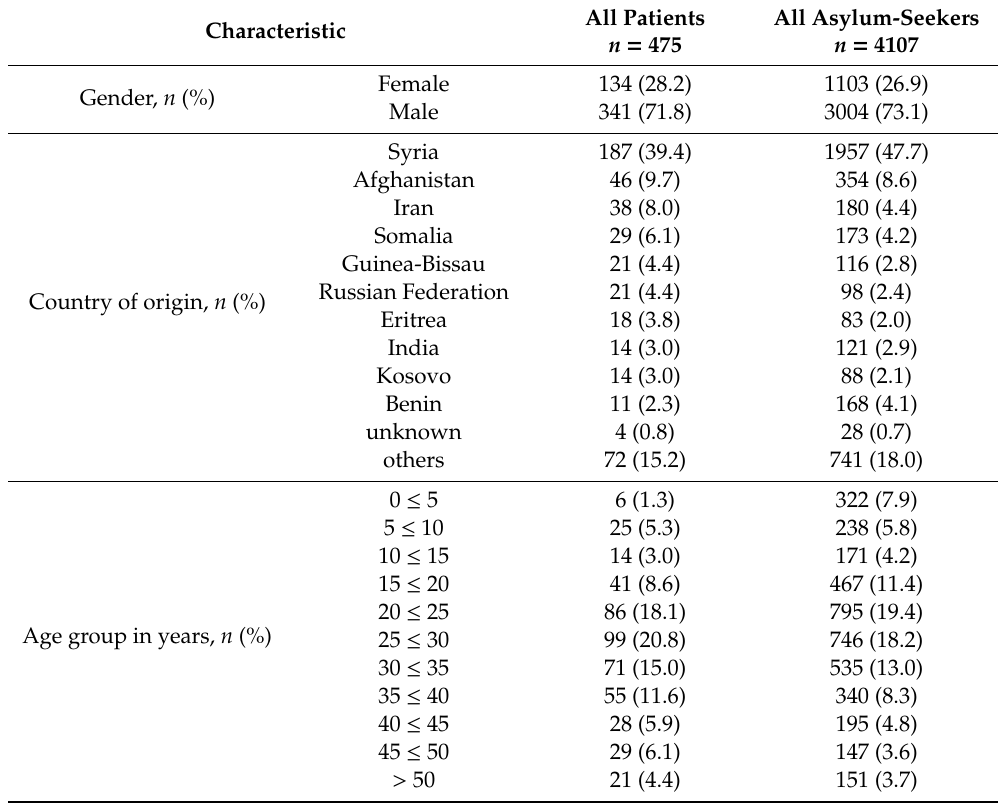
Table 1. Demographic characteristics of the study